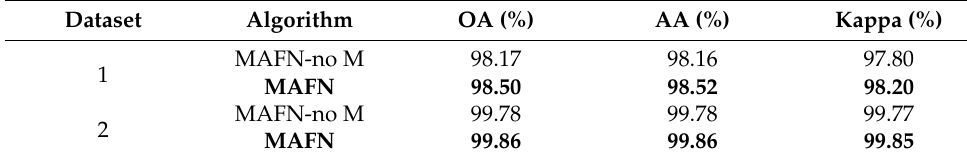
Table 3. Comparison of methods with/without multi-scale module on the two datasets.